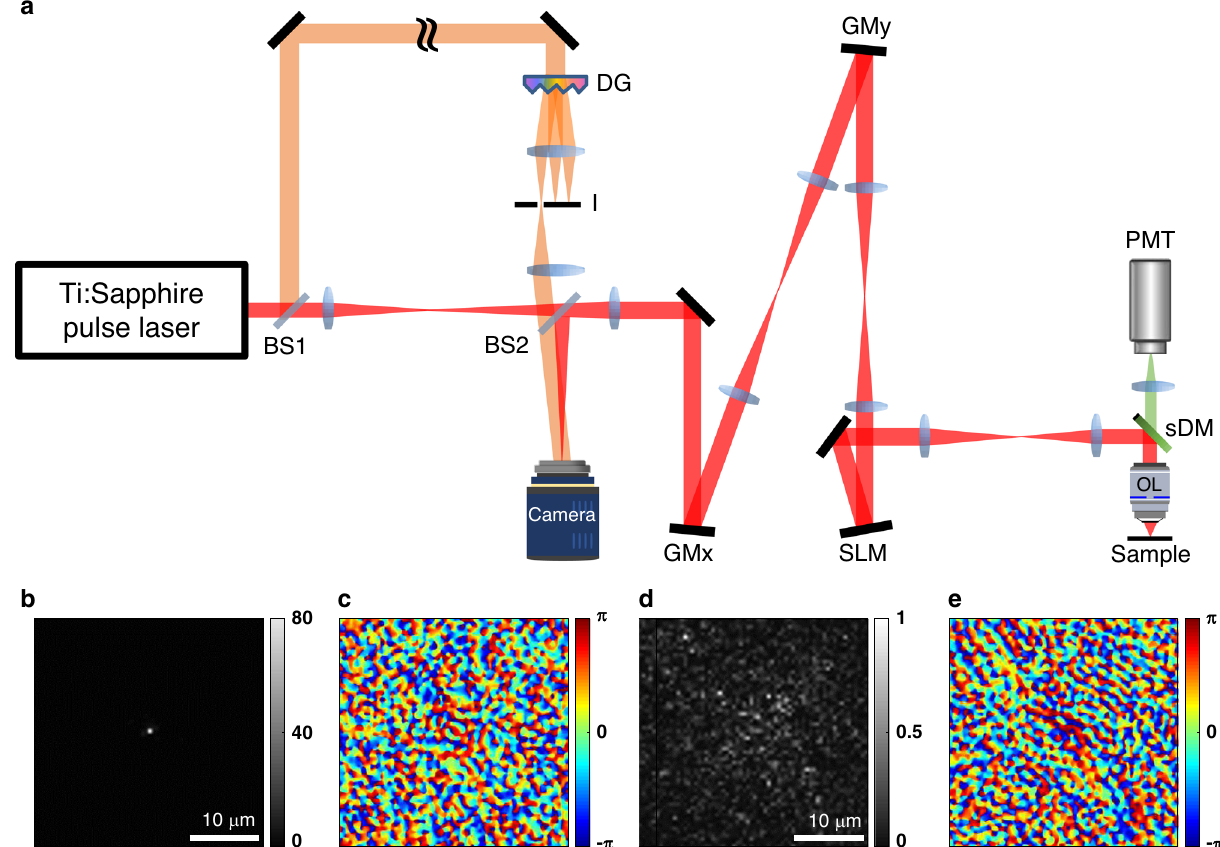
Fig. 1 Experimental schematic of laser-scanning re fl ection-matrix microscopy. a Experimental schematic; BS1 and BS2 beam splitters. The sample and reference beams are colored in red and orange, respectively, for visibility. GMx and GMy, galvanometer mirrors for scanning the sample beam along x and y axes, respectively. SLM spatial light modulator, sDM short-pass dichroic mirror, OL objective lens, PMT photomultiplier tube, DG diffraction grating, P pinhole. b , c Intensity and phase images of the re fl ected wave E cam ( r cam ; r i ), from the sample, respectively, for samples without aberrations. d , e Same as b and c , but for an aberrating sample. Color bars in b and d indicate intensity normalized by the maximum intensity in d . Color bars in c and e indicate phase in radians. Scale bars, 10 µ